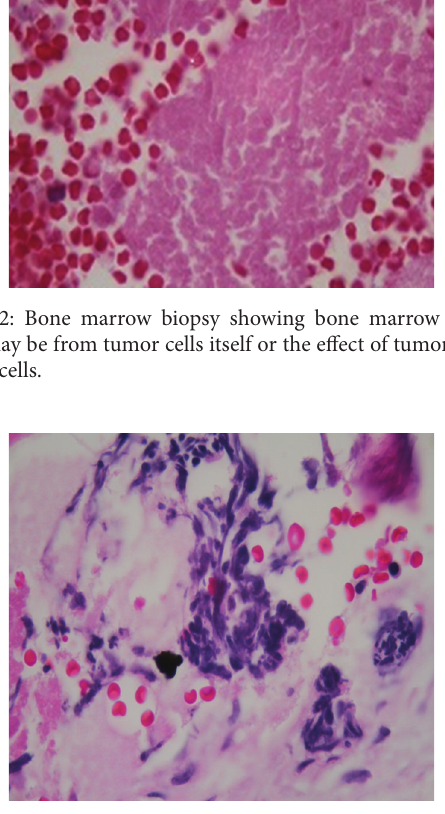
Figure 3: Bone marrow smear showing atypical small cells with sparse acidophil cytoplasm, lobulated and rounded nuclei, and compact